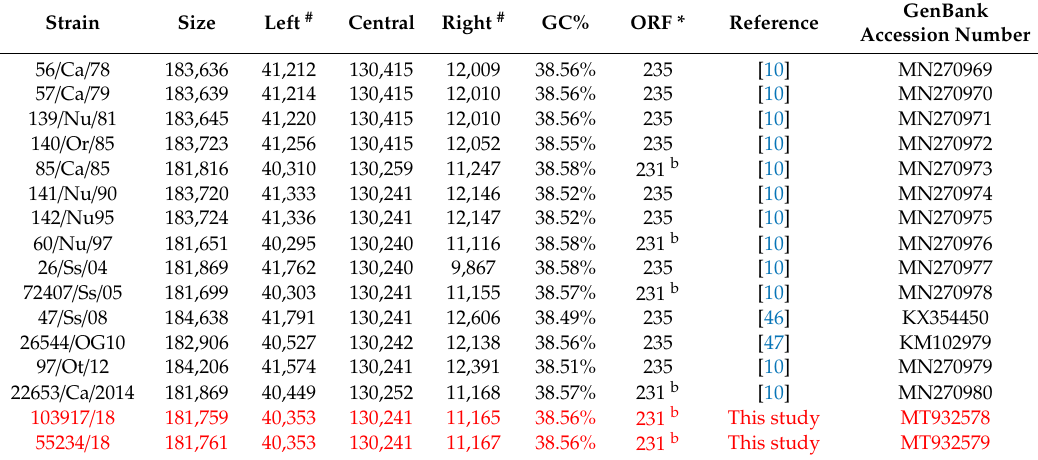
# Left and right refer to the left and right variable regions. The left variable region includes nucleotides from 5 (cid:48) -end to the beginning of A224L gene. The right variable region includes nucleotides from the end of DP238L gene to 3 (cid:48) –end. Size, left, and central right are expressed in bp. * ORF, open reading frame. b KP86R, KP96L, DP93R and DP86L, located into the ITRs, are